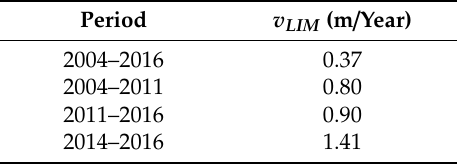
Table 2. Values of v LIM for di ff erent time windows.